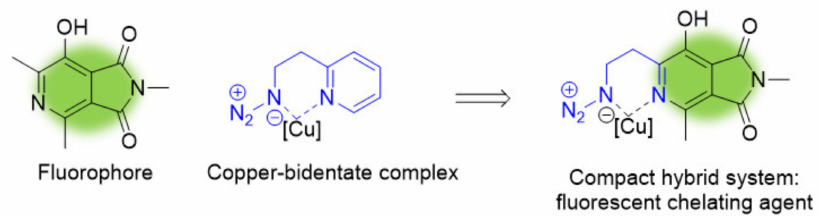
Figure 2. Fluorophore-based cooper(I) ligand for CuAAC-mediated fluorescent